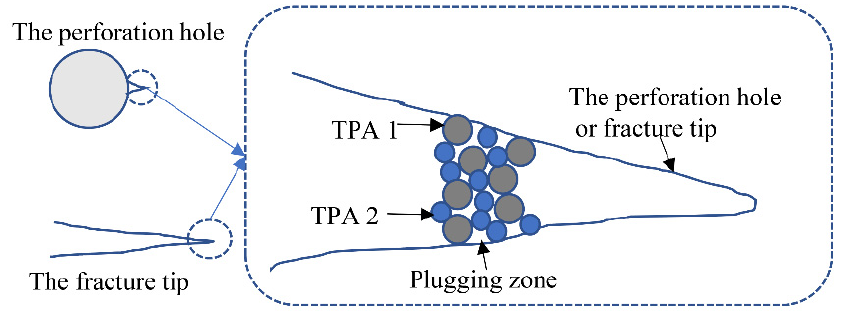
Figure 1. Schematic diagram of temporary plugging mechanism.